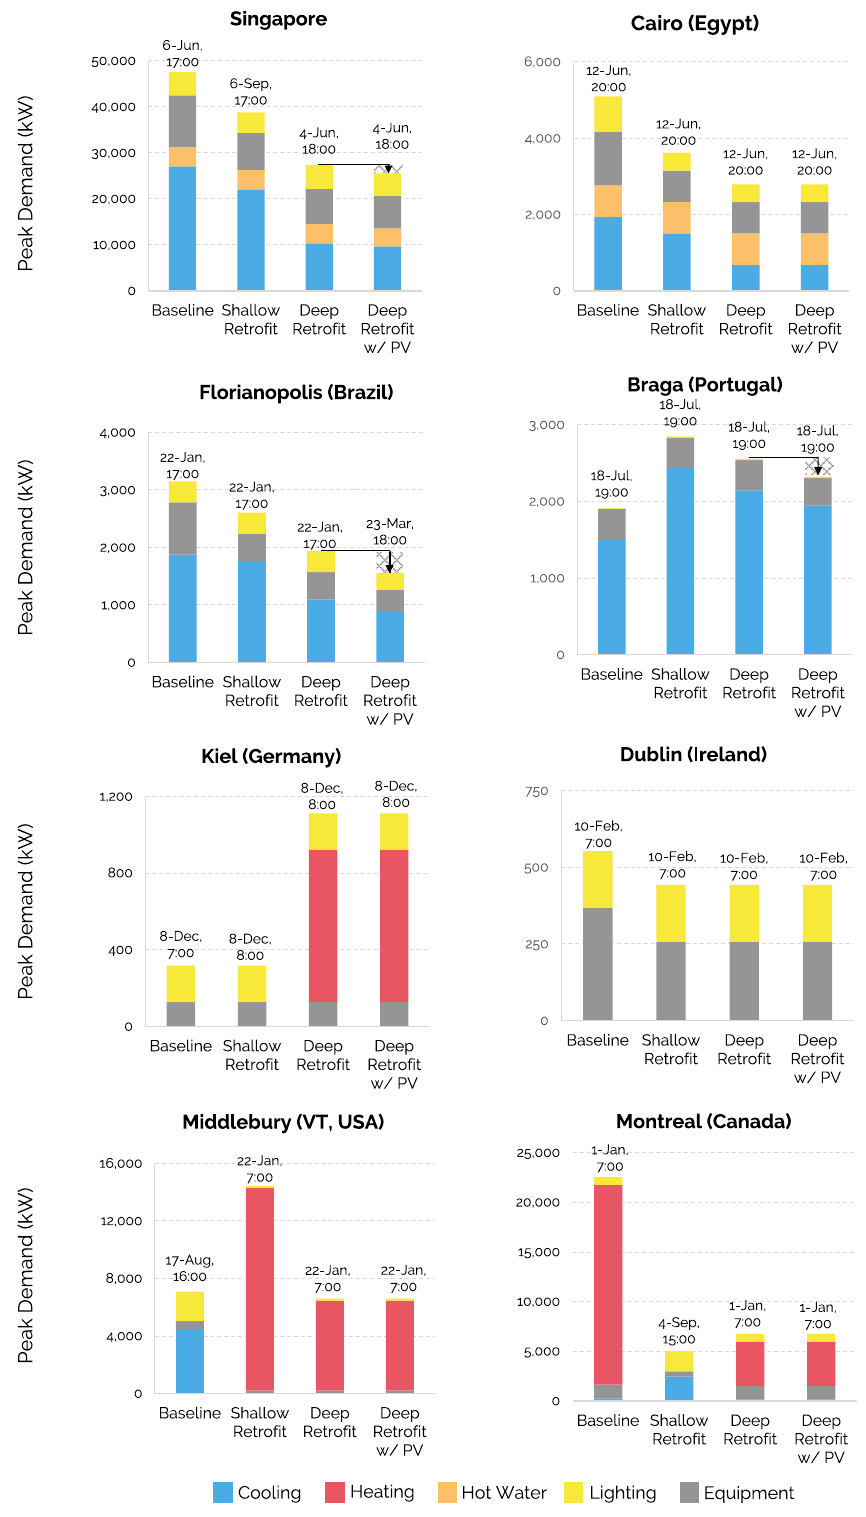
Fig.3|Theannualbuilding-relatedelectricpeakdemandforbaseline,shallow, and deep retro fi t scenarios, including 100% rooftop photovoltaics deploy- ment. Thetimestampovereachcolumnmarksthehourintheyearwhenthispeak occurs.WeobservethatthedeploymentofrooftopPVdoesnotreducethepeakin